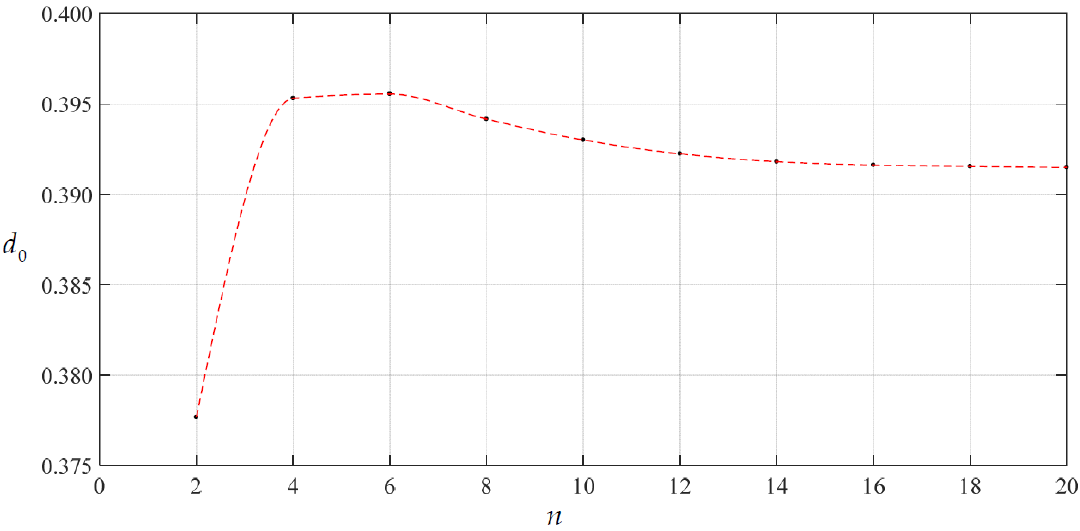
Figure 4. Variation of d 0 with n when H = 300